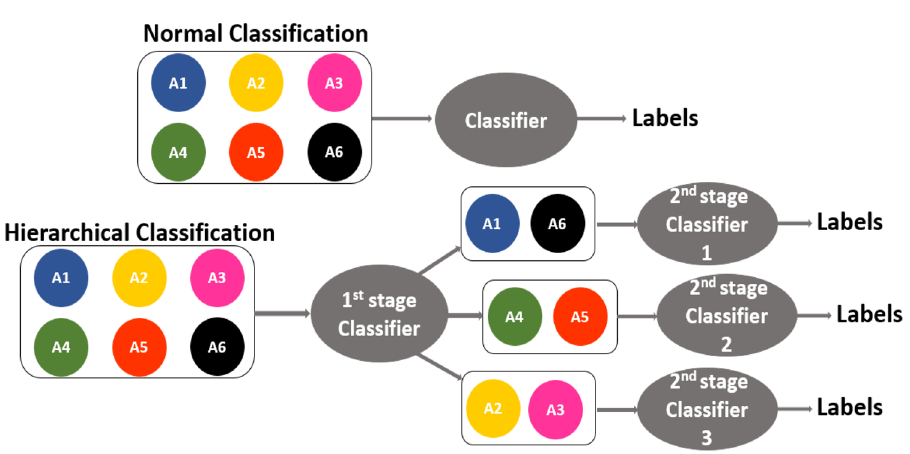
Figure 4. Example of conventional and hierarchical classification.